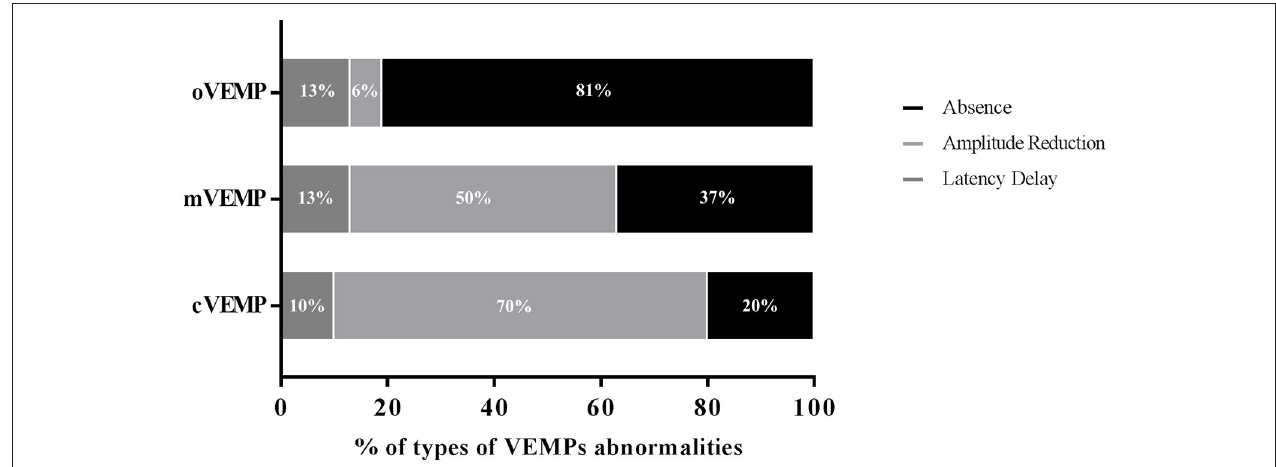
FIGURE 4 | Pattern of the abnormalities detected in iRBD patients in each of the three VEMPs. cVEMP, cervical VEMP; mVEMP, masseter VEMP; oVEMP, ocular VEMP.